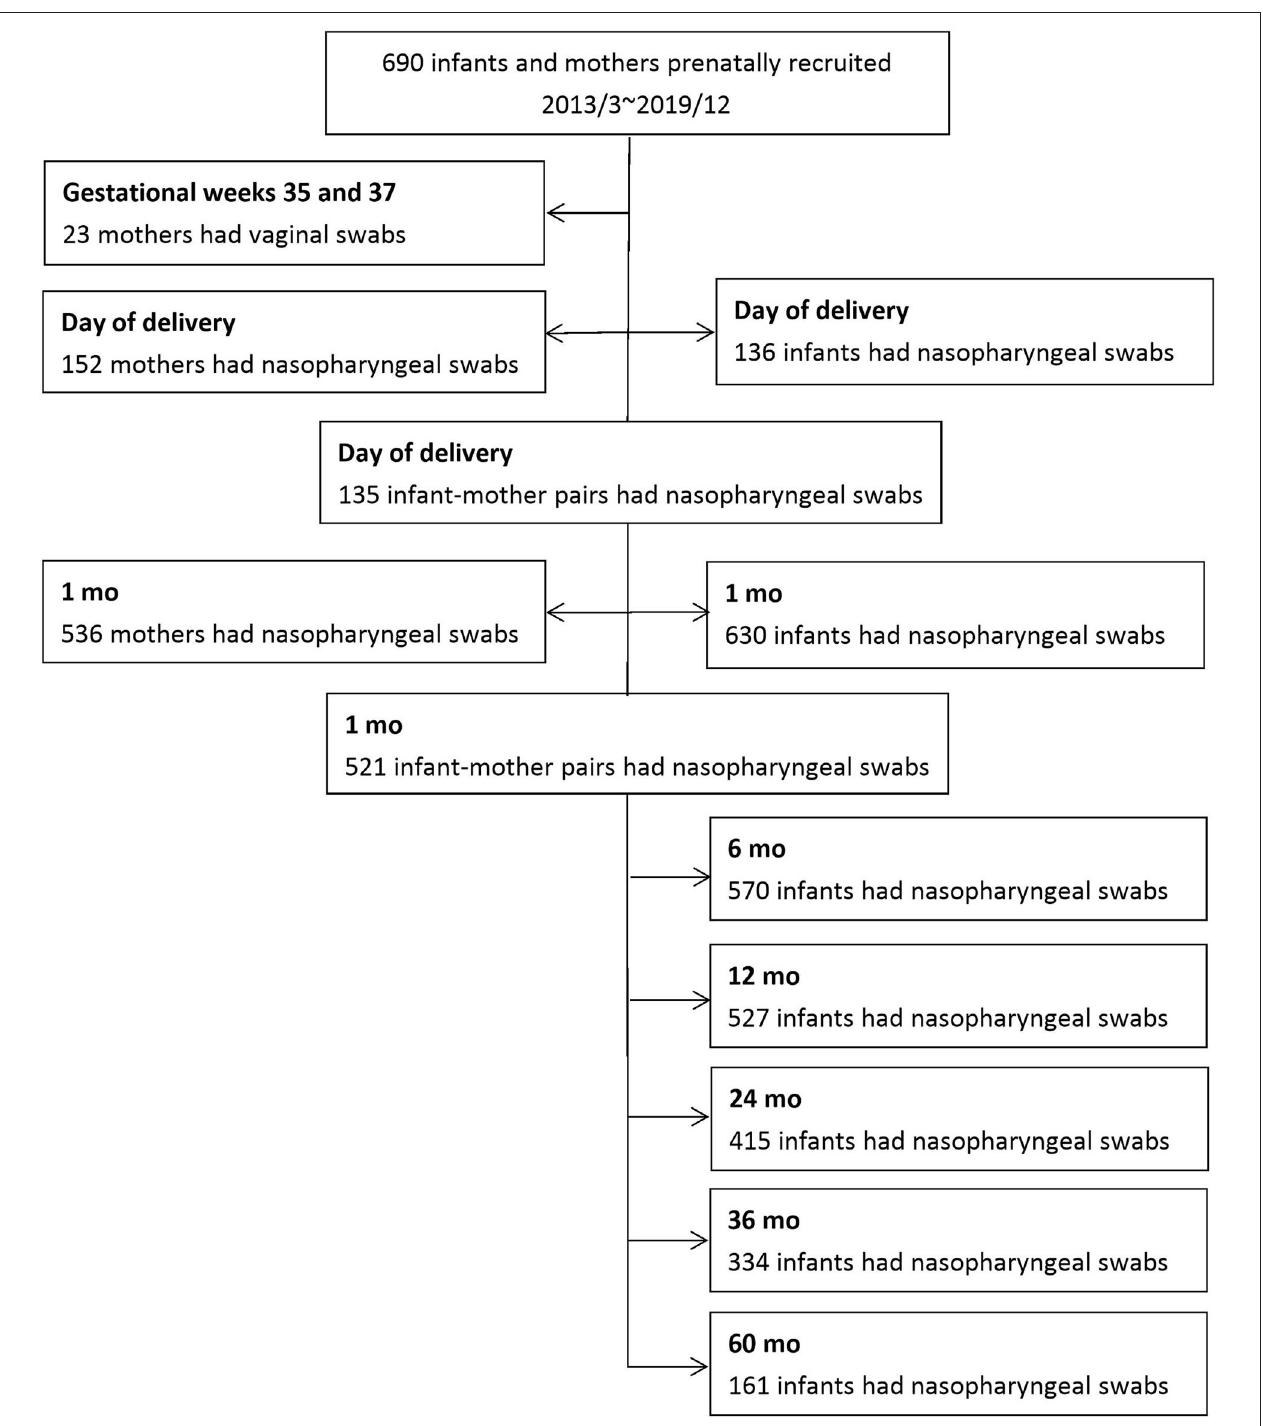
FIGURE 1 | Flowchart of enrollment during the study period.